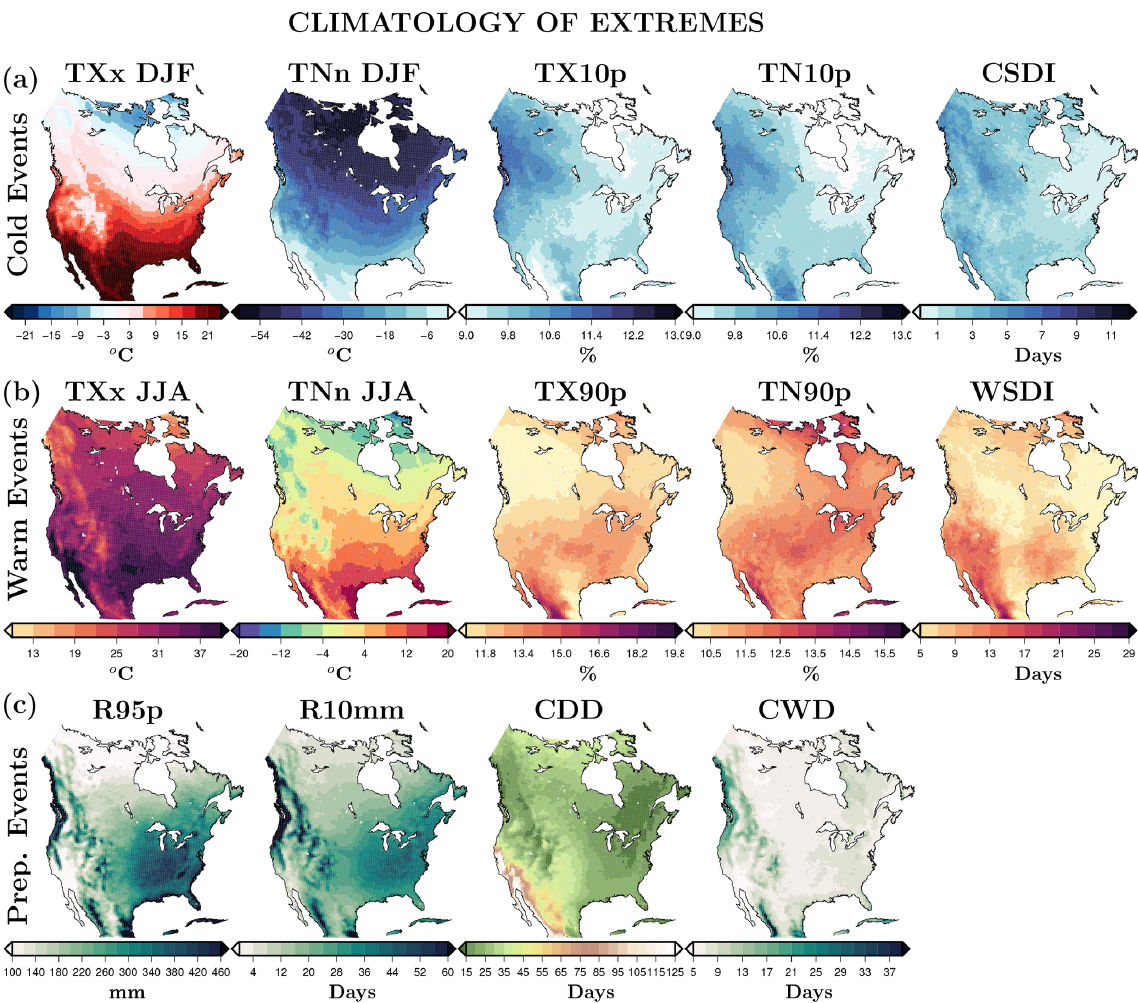
Figure 3. Climatology of extreme indices associated with cold temperature events (a) , warm temperature events (b) and precipita- tion events (c) for the ensemble mean, formed by the four WRF simulations (Table 2: TXx/TNn, maximum/minimum value of the maximum/minimum daily temperatures; TN10p/TX10p, percentage of cold nights/days; TN90p/TX90p, percentage of hot nights/days; CSDI/WSDI, cold/warm spell duration index; R95p, total annual precipitation in wet days; R10mm, number of wet days in a year; CDD/CWD, consecutive dry/wet days). The climatology of each index is estimated as the mean of each extreme index at each grid cell for the analysis period